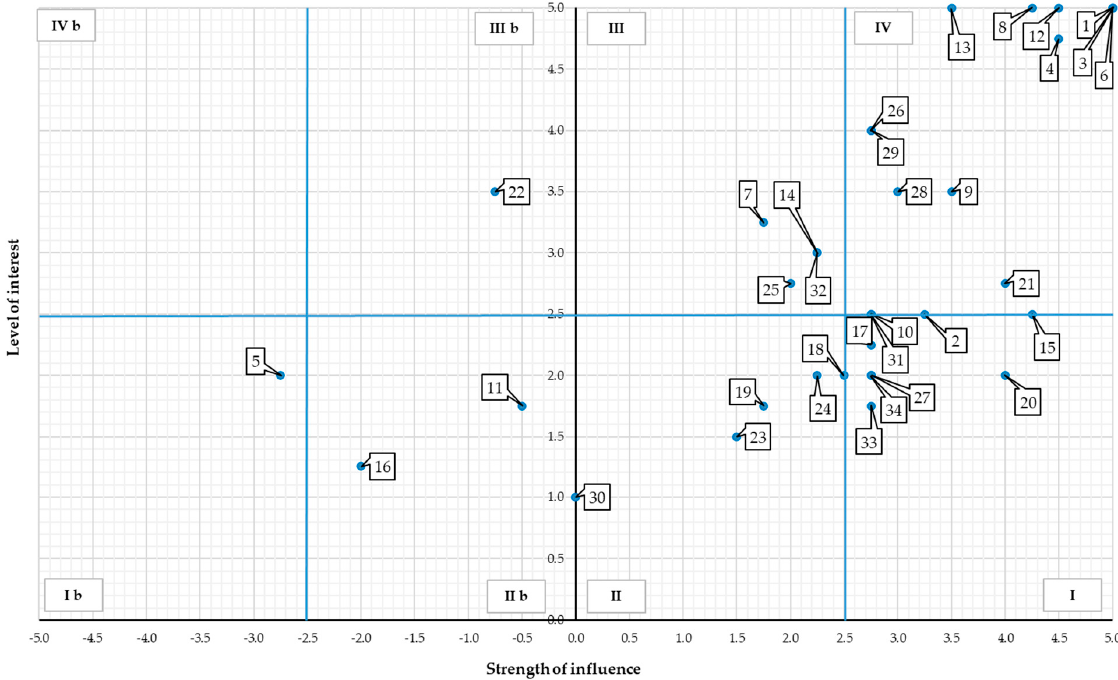
Figure 3. Stakeholder map in the business ecosystem: strength of influence—degree of predictability of change.